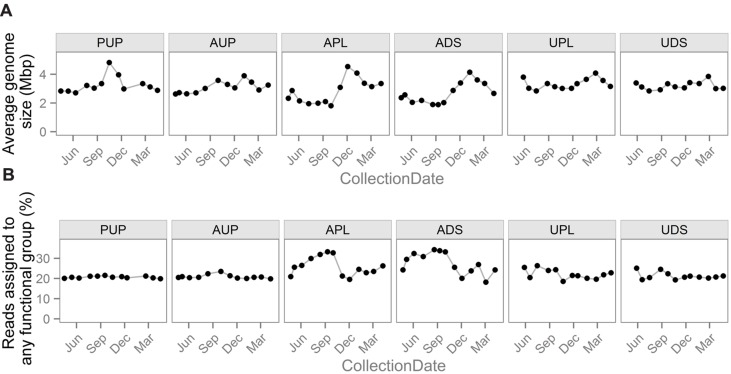
Normalization factors used in different strategies to enable comparisons of gene group abundances between samples. Notable differences exist among sites and over time in both (A) average genome size and (B) the percentage of reads assigned to any gene functional group. This variability demonstrates how normalization schemes using these values can have a drastic effect on downstream analyses.